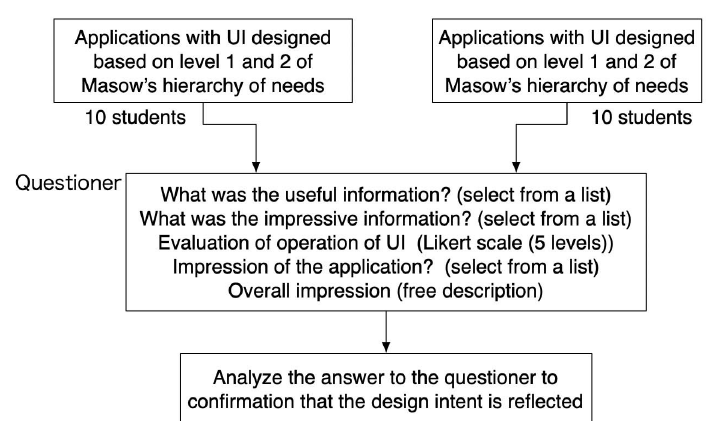
Figure 9. Two different designs of UI: the left one was designed based on layers 1 and 2, and the right one was designed based on layers 5 and 6.